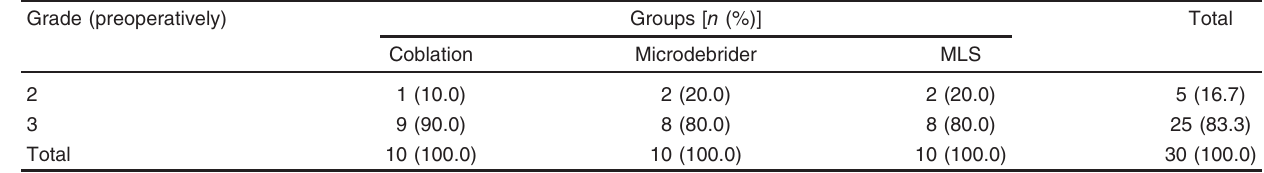
Table 2 Comparison between the three groups regarding the degree of dysphonia (preoperatively) Grade (preoperatively)